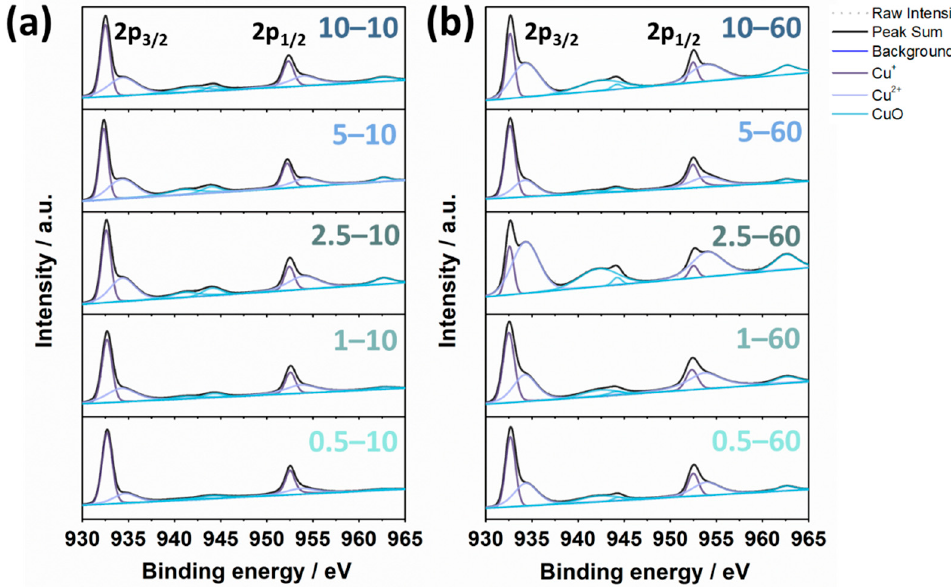
Figure 5. XPS spectra of the samples sulfurized from the Na 2 S solution with different concentrations (c = 0.5–10 mM) for reaction times of 10 and 60 min: the Cu 2 p region of the samples reacted for ( a ) 10 min and ( b ) 60 min.